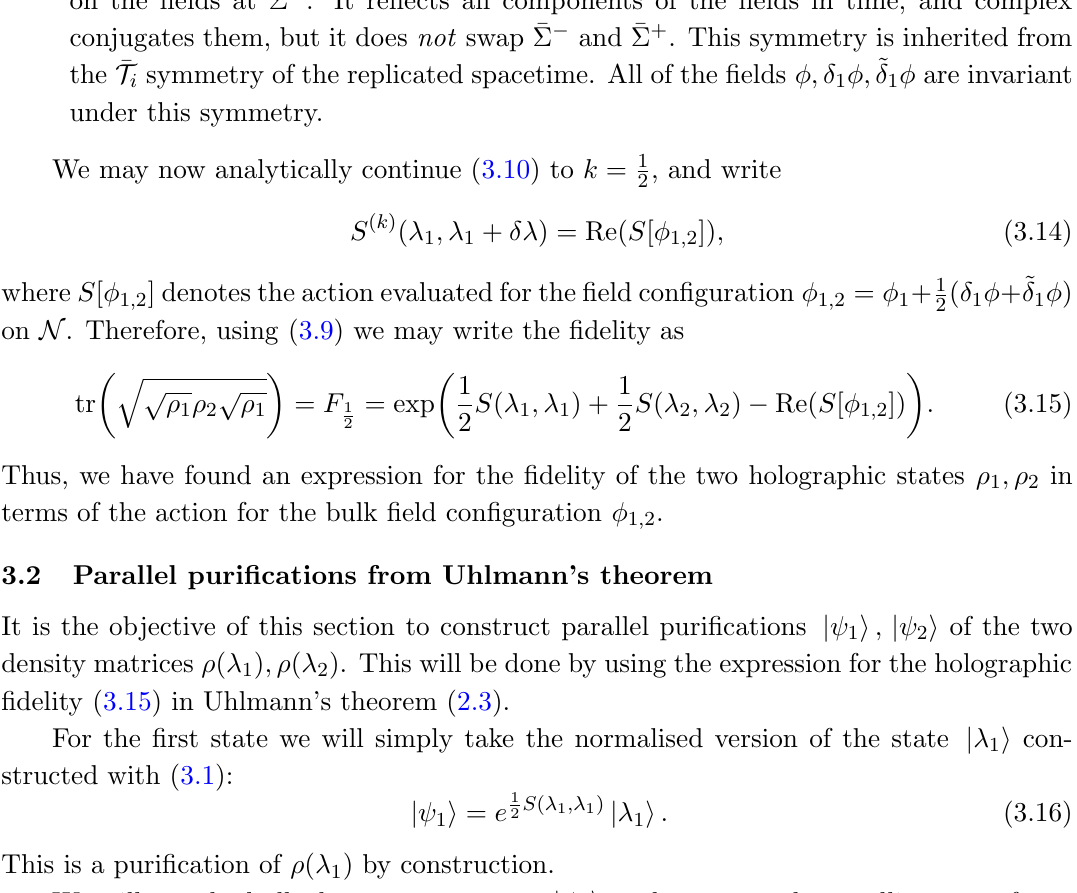
(cid:30); ~ (cid:14) (cid:30) are invariant 1 1